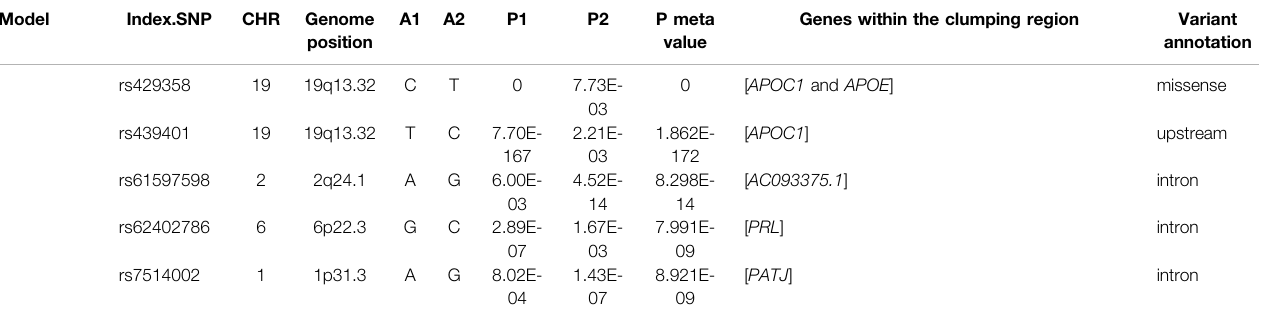
TABLE 2 | ( Continued ) Cross-trait meta-analysis results between Alzheimer ’ s disease and sleep-related phenotypes ( P meta < 1.67 × 10 – 8 and single-trait p < 1 × 10 – 3